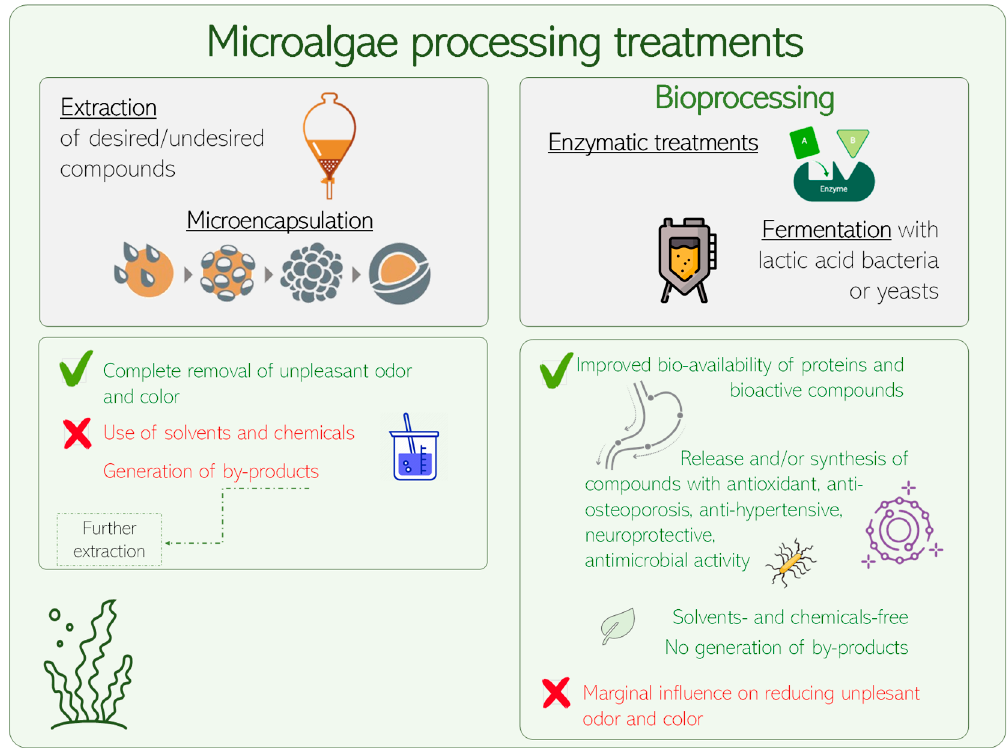
Figure 2. Illustration of the main advantages and limitations of microalgae processing treatments commonly proposed to improve their nutritional and functional potential .